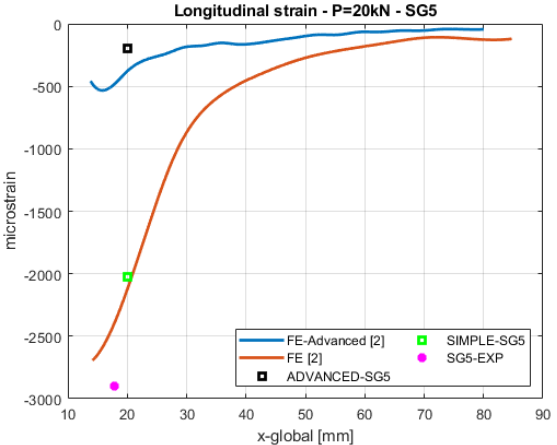
Figure 13. Strain comparison for SG 5 between static FE [1] and present numerical simulations. Experimental strain values are from Frulla et al. [1].